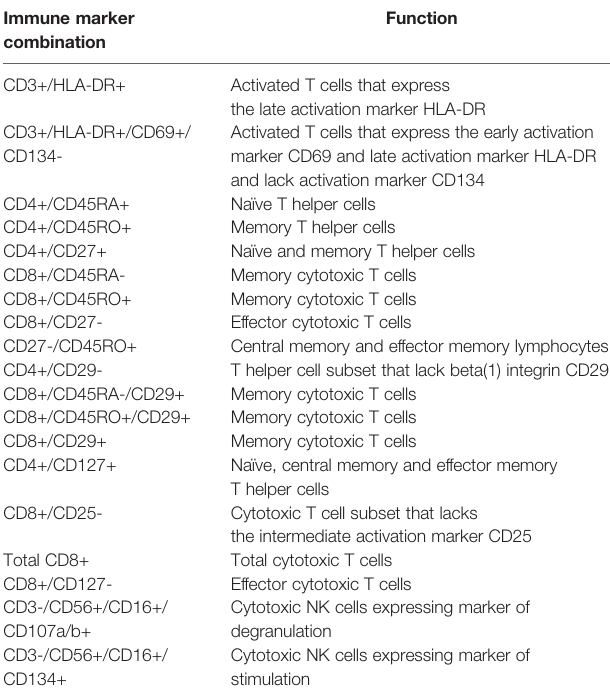
TABLE 2 | Immune marker combinations and corresponding function of cellular subsets that were identi fi ed as signi fi cantly contributing to the differences between case and control lymphocyte populations by the FIS